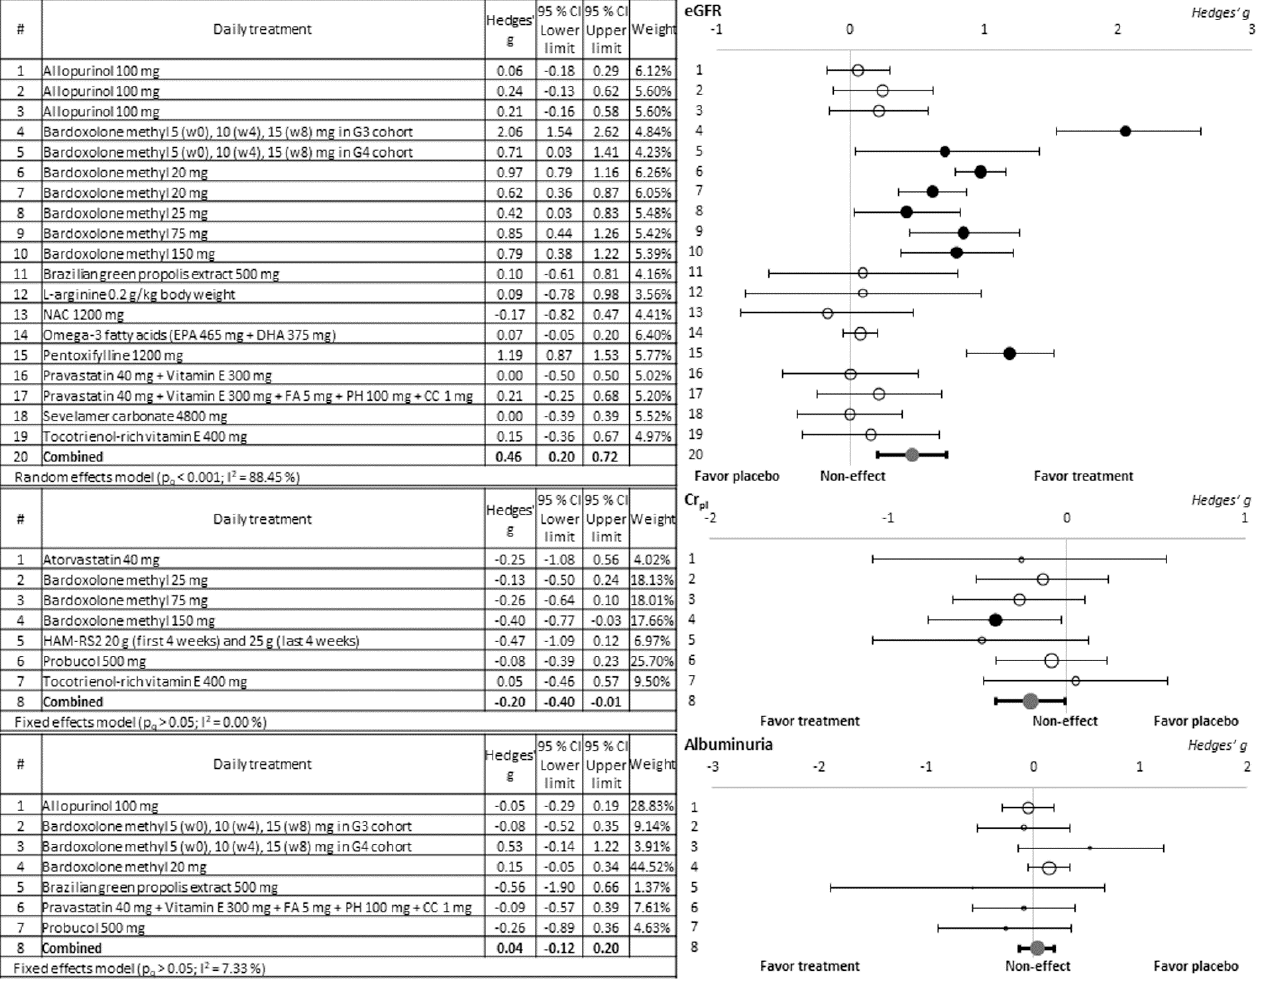
Figure 2. Forest plots in which the nephroprotection of the different treatments tested against CKD is compared to the placebo/control groups evaluated by means of different biomarkers of renal function. The effect size is measured as Hedges’ g ± 95% CI. CC: cyanocobalamin; CI: confidence interval; Cr pl : plasma creatinine; DHA: docosahexaenoic acid; eGFR: estimated glomerular filtration rate; EPA: eicosapentaenoic acid; FA: folic acid; NAC: N-acetylcysteine; PH: pyridoxine hydrochloride; w: week.